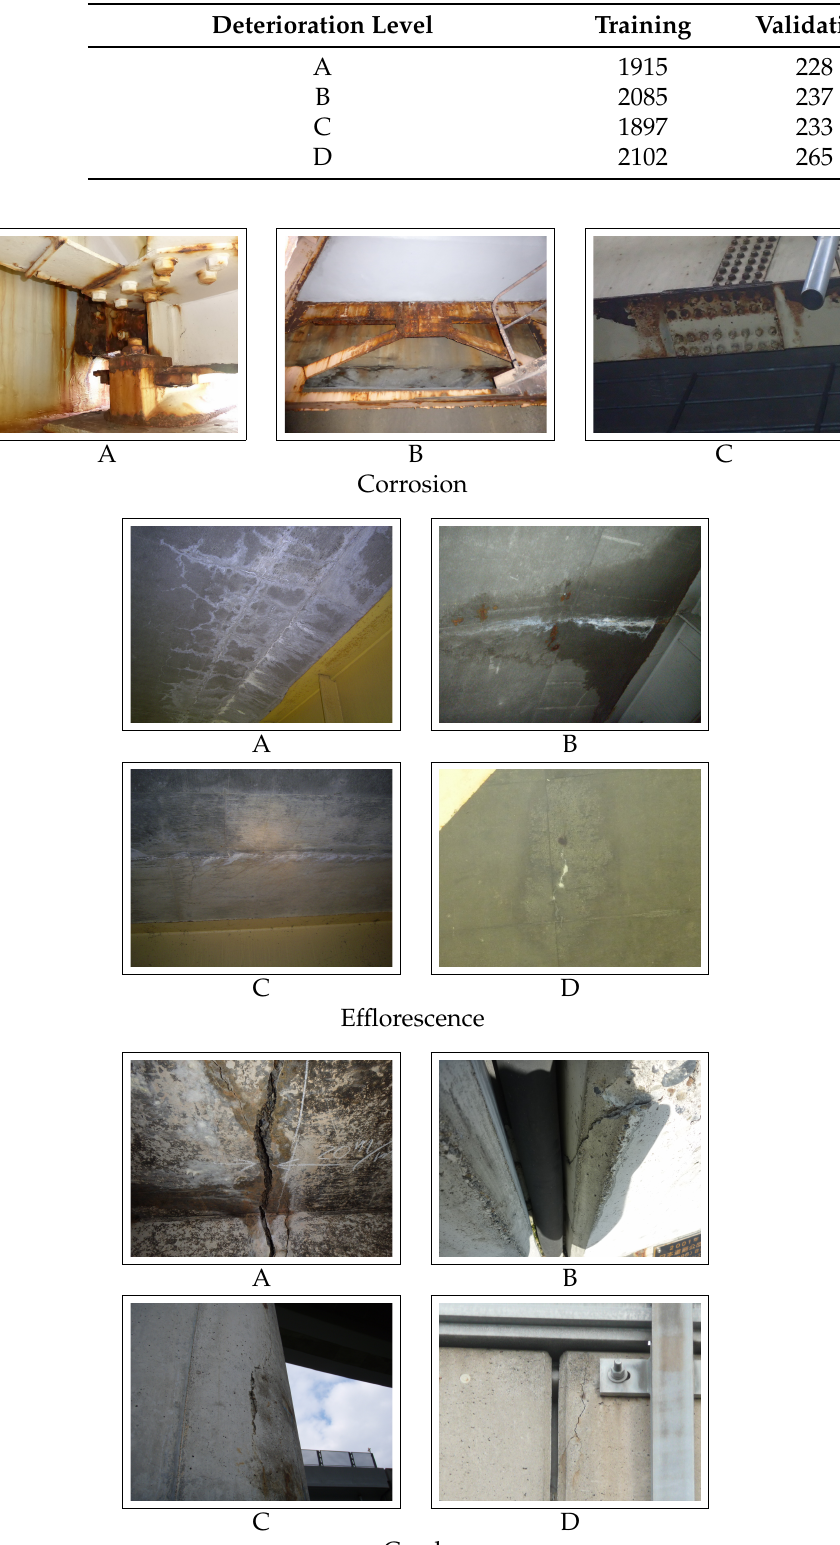
Figure 3. Examples of each type of distress with different